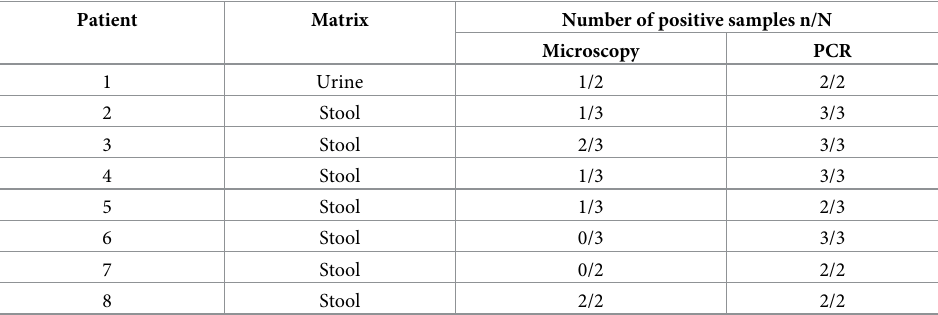
Table 2. Results of microscopic detection and Schistosoma PCR in iterative excreta